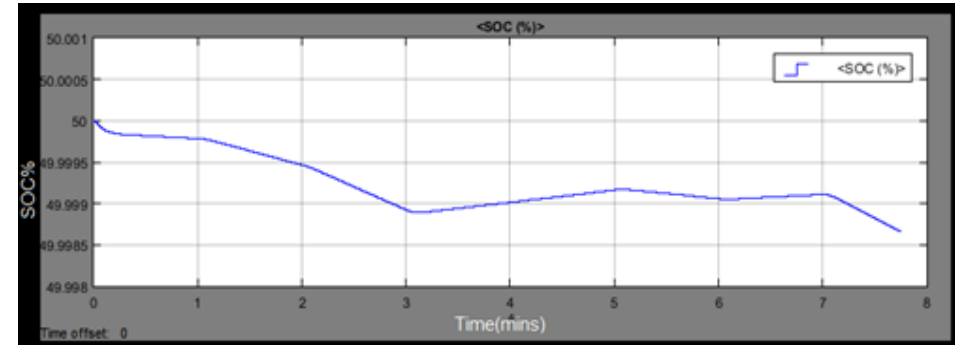
Figure 24. Battery discharging mode.